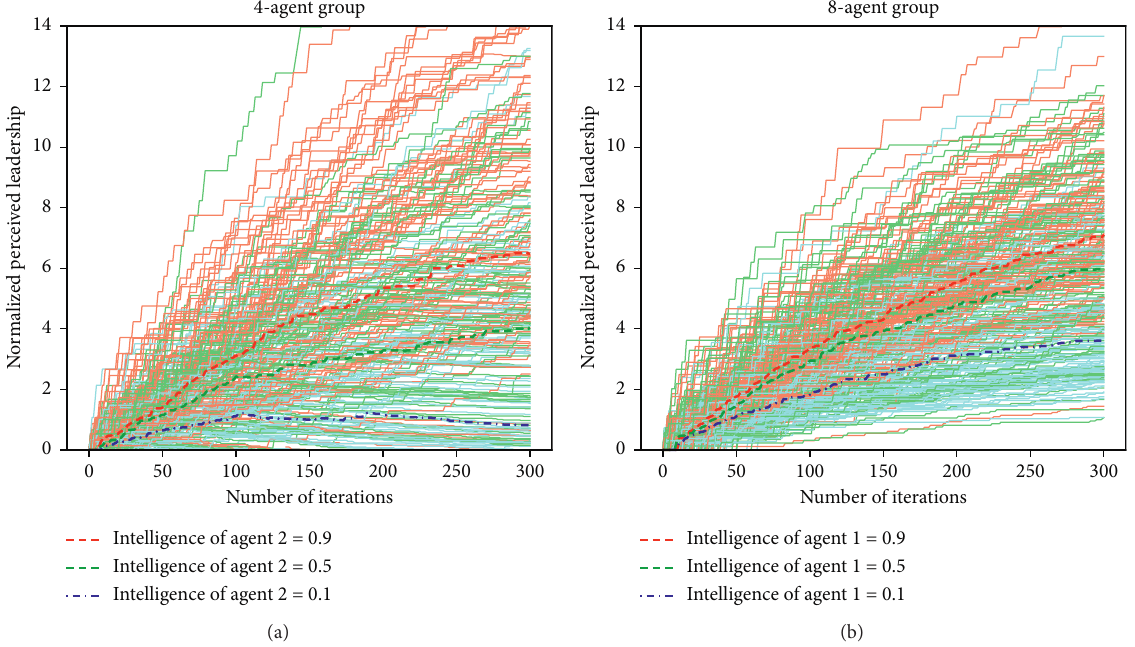
Figure 6: Perceived leadership of a certain agent (leader) with 3 levels of intelligence in 4-agent group (a) and 8-agent group (b). The thin lines show the results of 100 independent simulation runs, while the thick dotted lines represent the median of those 100 runs. Note that agents’ other attributes are defined in Tables 1 and 2.